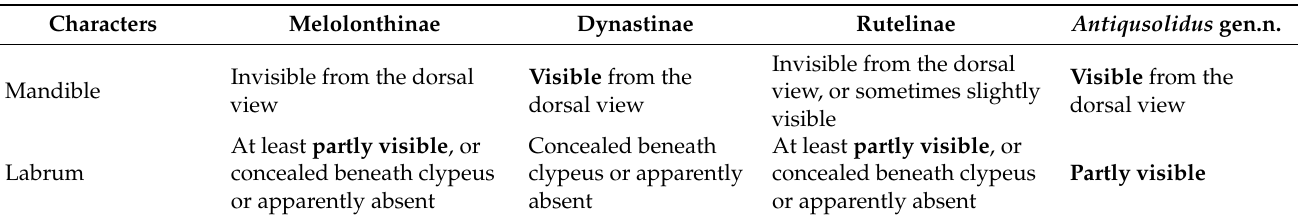
Table 1. Key characters to distinguish Melolonthinae, Dynastinae, Rutelinae and Antiqusolidus